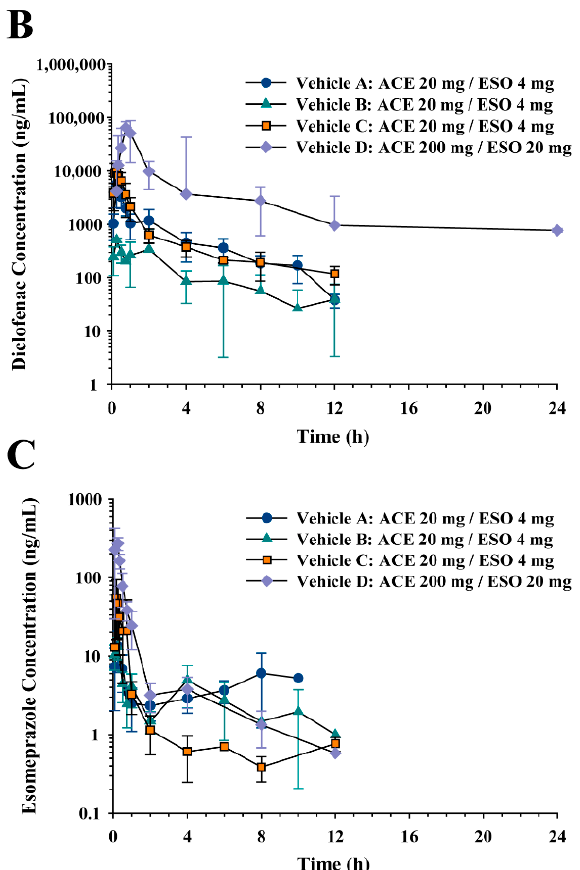
Figure 3. Average plasma concentration-time profiles of ( A ) aceclofenac, ( B ) diclofenac, and ( C ) esomeprazole following oral administration of vehicle A, B, C, and D containing aceclofenac (20 mg/kg for A, B, and C and 200 mg/kg for D) and esomeprazole (4 mg/kg for A, B, and C and 20 mg/kg for D) in rats.